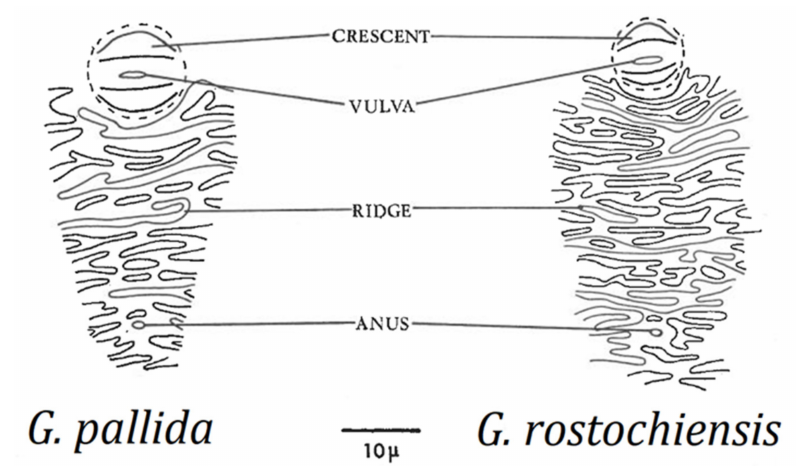
Figure 3. Vulval-anal ridge patterns for G. pallida and G. rostochiensis (after Stone [52]). Table 2. Dichotomous morphological key to species of the genus Globodera . (after Subbotin et al. [7] and EPPO [17], with the addition of G. agulhasensis [64] and G. sandveldensis